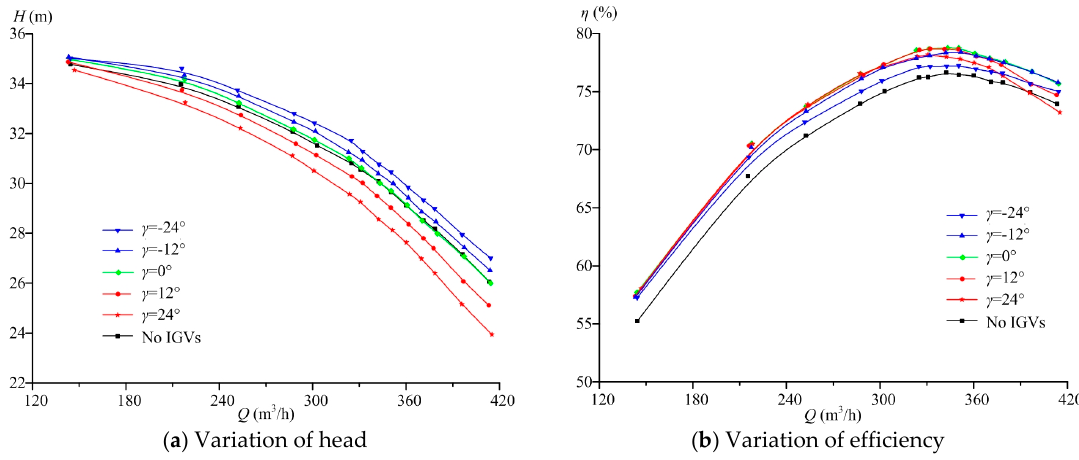
Figure 5. Experimental results of head and efficiency in pumps without and with IGVs.